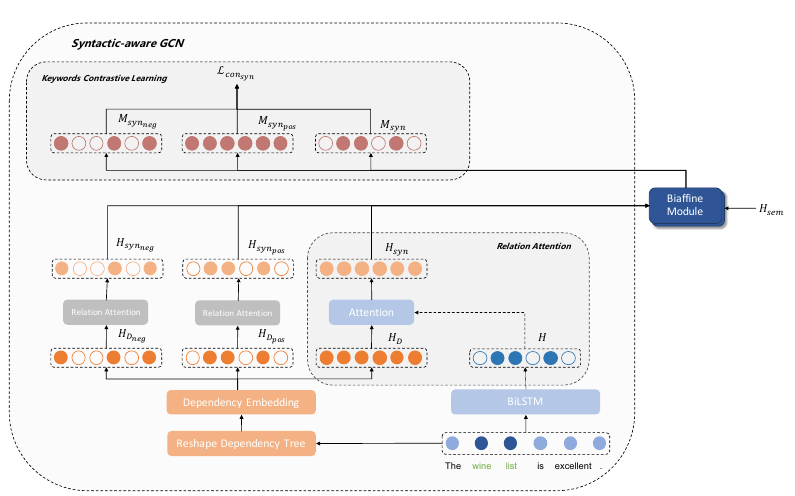
Figure 4. Architecture of syntactic-aware GCN